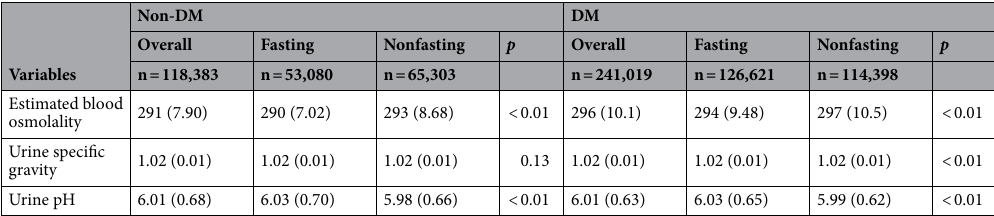
Table 1. Comparison of demographic and biochemical profiles of ontologically fasting samples with concomitant HbA1c measurement according to DM and theoretical fasting status. Values for continuous and categorical variables are expressed as mean (standard deviation) and frequency (%), respectively. Levels of glucose, HbA1c, and other biochemical variables were measured on the same day. P value indicates the significant difference of variables between theoretically fasting and nonfasting samples. BMI body mass index, LDL low-density lipoprotein, HDL high-density lipoprotein, BUN blood urea nitrogen, AST aspartate aminotransferase, ALT alanine transaminase.